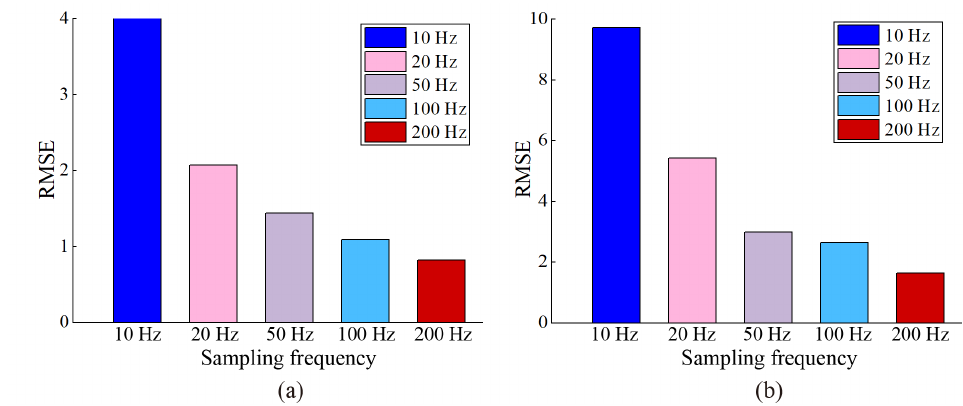
Figure 15. Relationship between sampling frequency and prediction performance using small coarse gravel: ( a ) throttle prediction ( b ) state prediction. Table 4. The RMSE of throttle value and state under different sampling